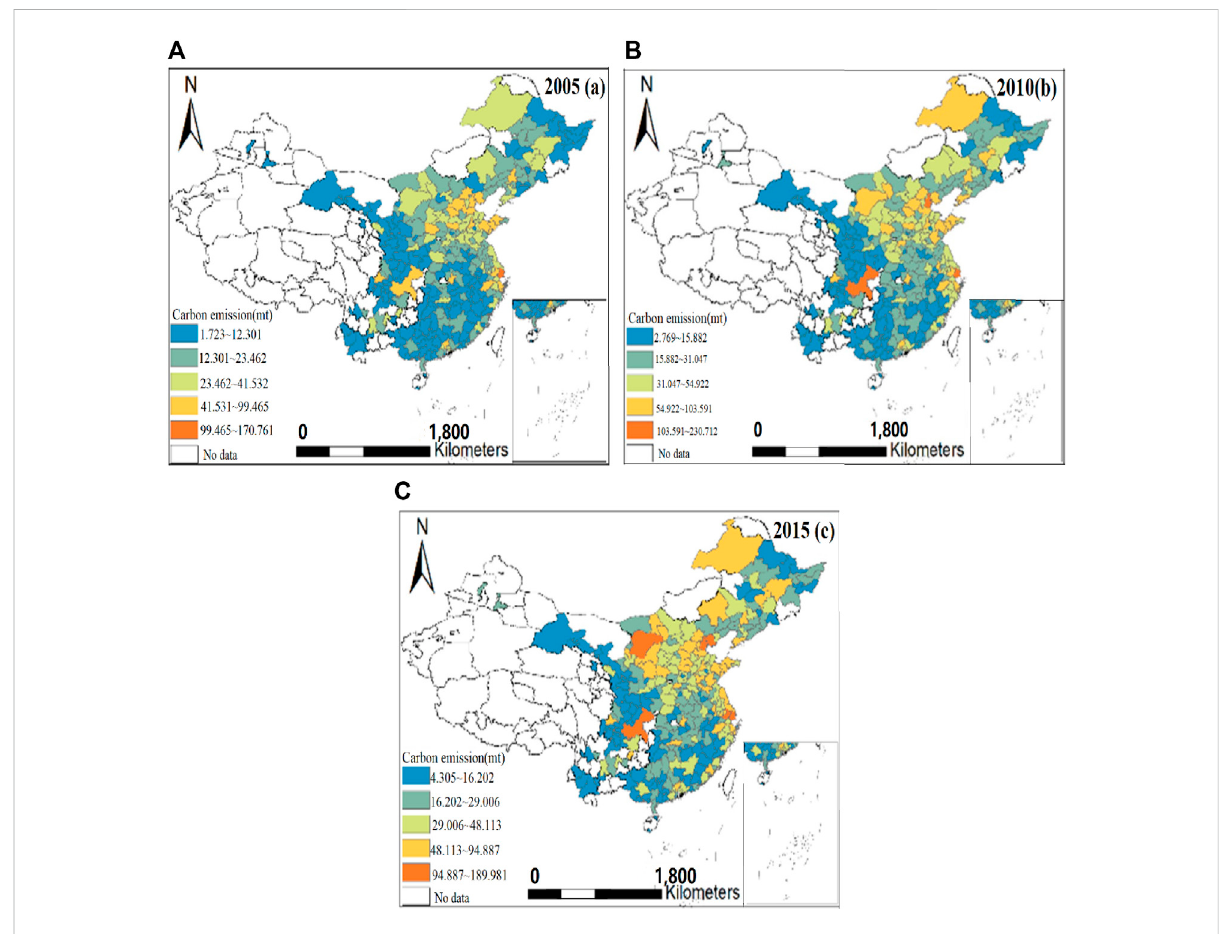
Carbon emissions; (A) for 2005, (B) for 2010, (C) for